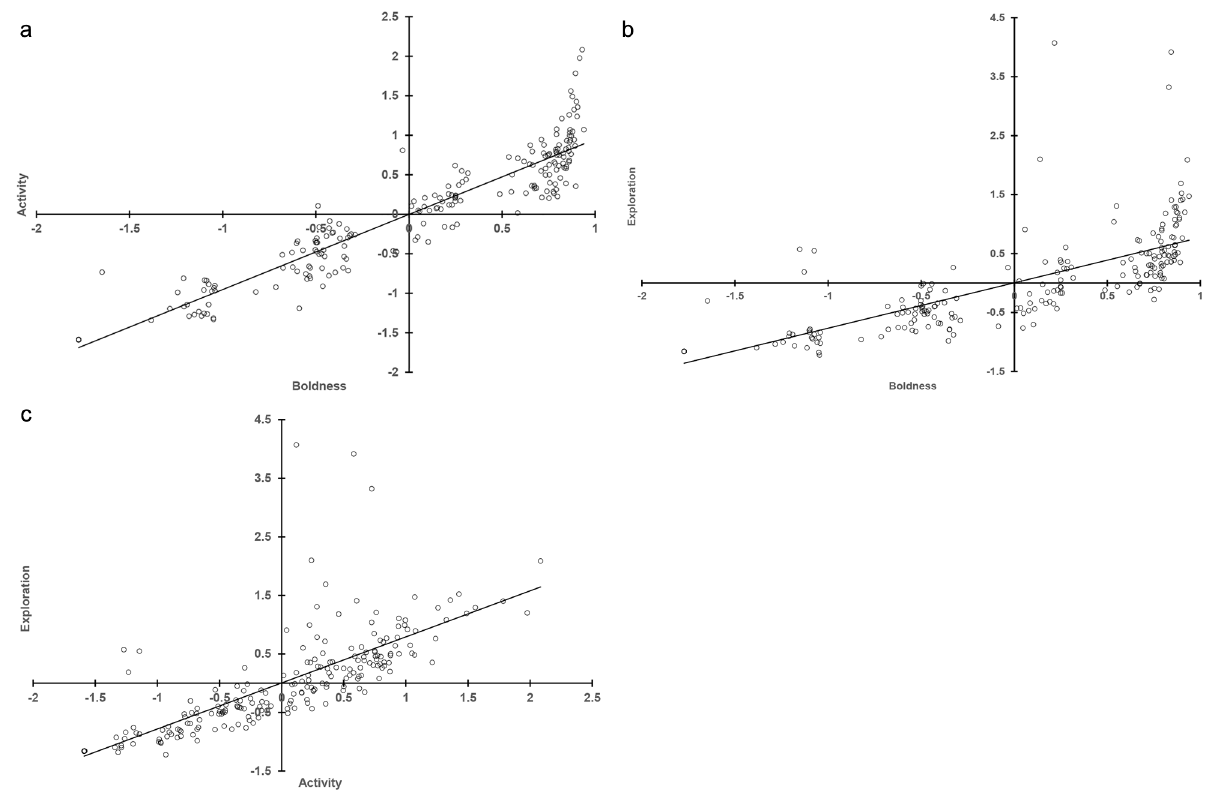
Fig. 3 Correlation of PC scores between paired behavioral categories (a) boldness-activity, (b) boldness-exploration, and (c) activity-exploration assessed for eastern bent-wing bats in tunnel box